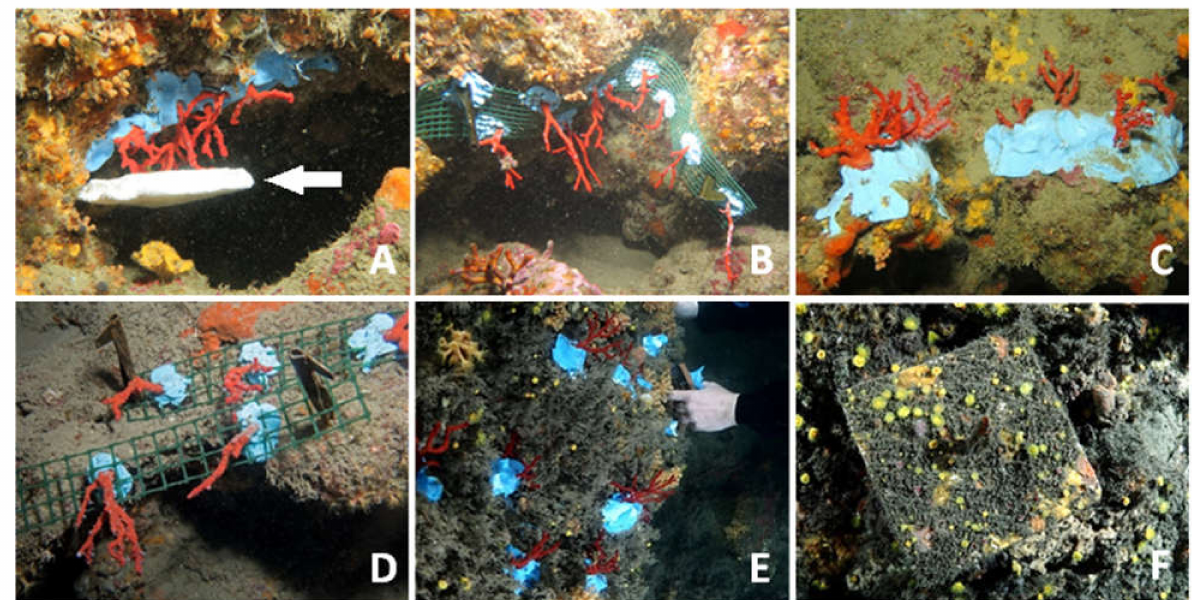
Figure 2. Images of the different transplantation techniques in shallow water directly after trans- plantation: ( A ) Polystyrene method, the arrow points at the polystyrene sheet; ( B ) Grid under crevices method; ( C ) Epoxy putty on rocks method; ( D ) Grid on rocks method; ( E ) Shallow colonies transplanted to deep water method; ( F ) Larval enhancement experiment on PVC